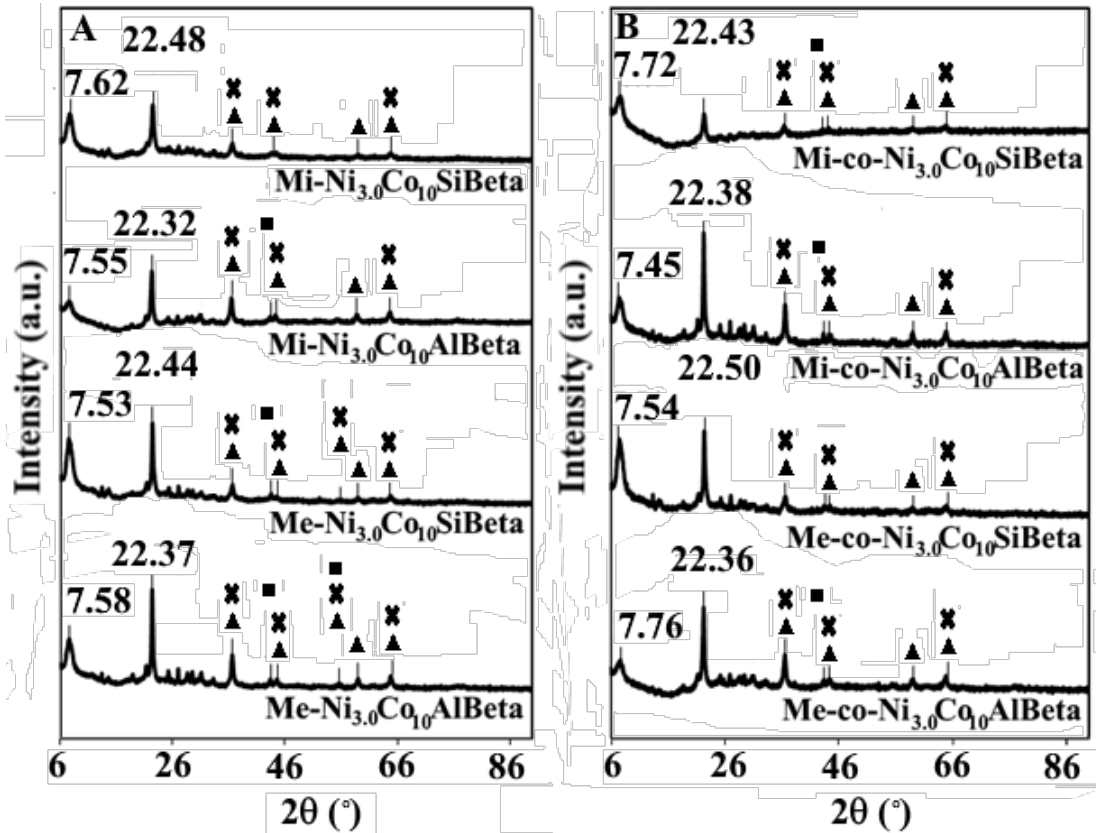
Figure 1. XRD patterns of ( A ) Me-Ni 3.0 Co 10 AlBeta, Mi-Ni 3.0 Co 10 AlBeta, Me-Ni 3.0 Co 10 SiBeta, Mi-Ni 3.0 Co 10 SiBeta and ( B ) Me-co-Ni 3.0 Co 10 AlBeta, Mi-co-Ni 3.0 Co 10 AlBeta, Me-co-Ni 3.0 Co 10 SiBeta, Mi-co-Ni 3.0 Co 10 SiBeta recorded at room temperature and ambient atmosphere ( (cid:78) —Co 3 O 4 , (cid:4) —NiO, (cid:54) —NiCo 2 O 4 ).